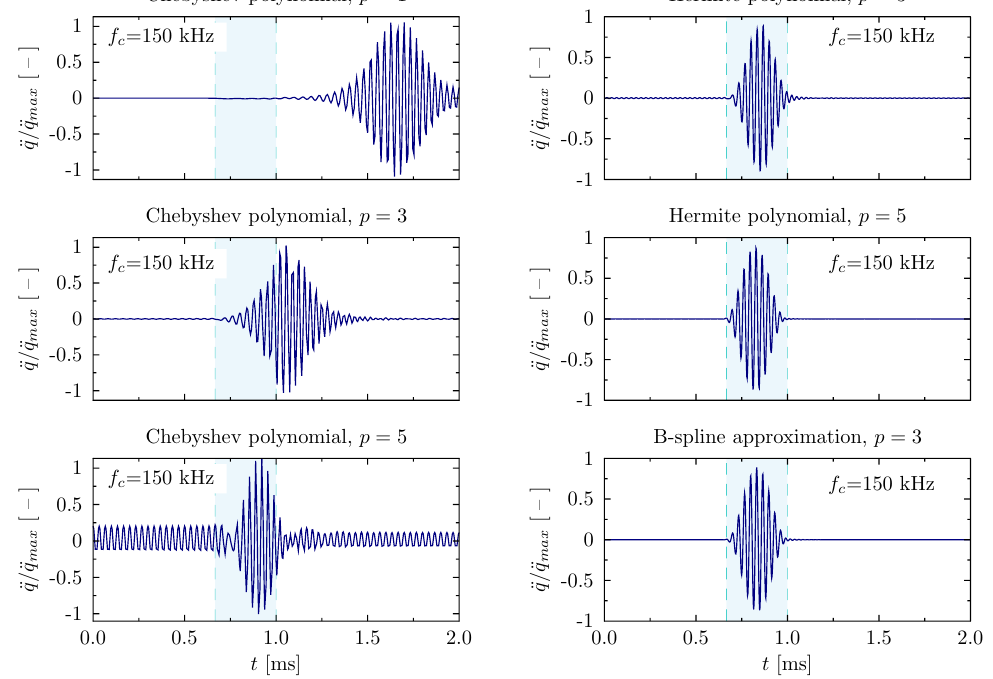
Figure 9. Wave propagation patterns of the rod calculated based on different approximation polynomials for the carrier frequency f c = 150 kHz, in the case of the rod of free